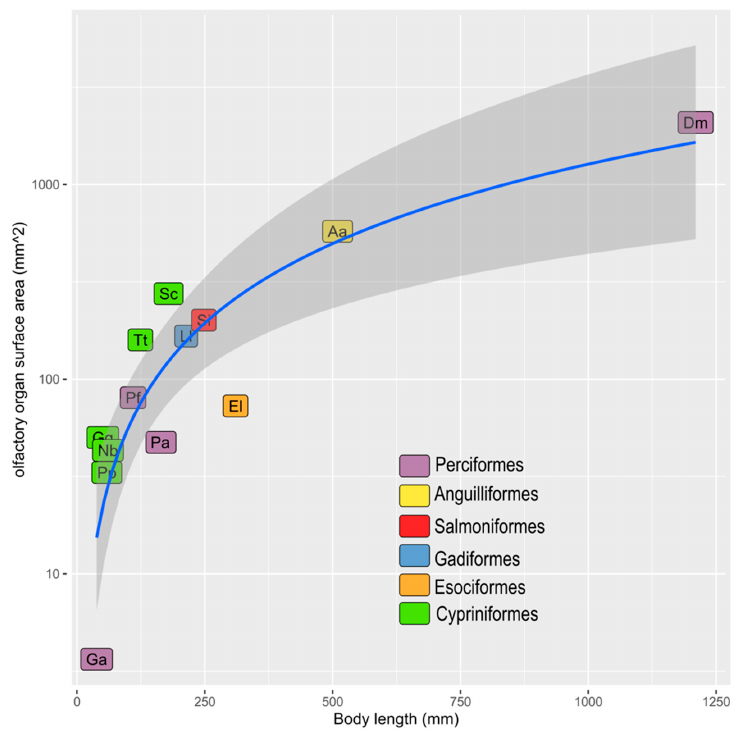
Figure 5. Scatter plot representing data in Table 1. The regression function is y = 0.0524·× 1.3654 (R2 = 0.9756). Aa: Anguilla anguilla , Dm: Dissostichus mawsoni , El: Esox lucius , Ga: Gasterosteus aculeatus , Gg: Gobio gobio , Ll: Lota lota , Nb: Nemachilus barbatulus , Pa: Pleuragramma antarcticum , Pf: Perca fluviatilis , Pp: Phoxinus phoxinus , Sc: Squalius cephalus , Si: Salmo irideus , Tt: Tinca tinca .